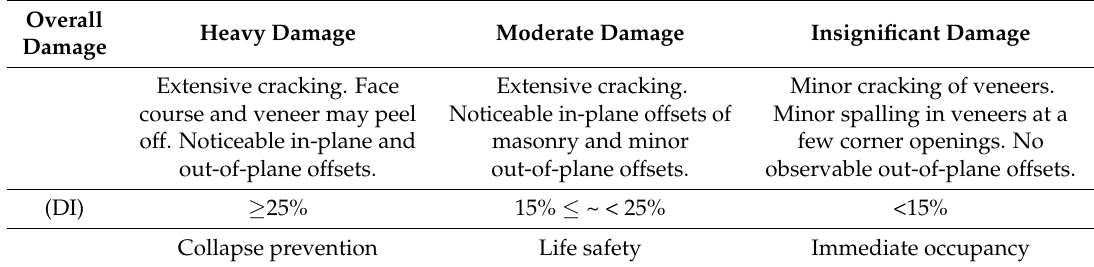
Table 2. Proposed structural performance levels for un-reinforced masonry. DI, damage